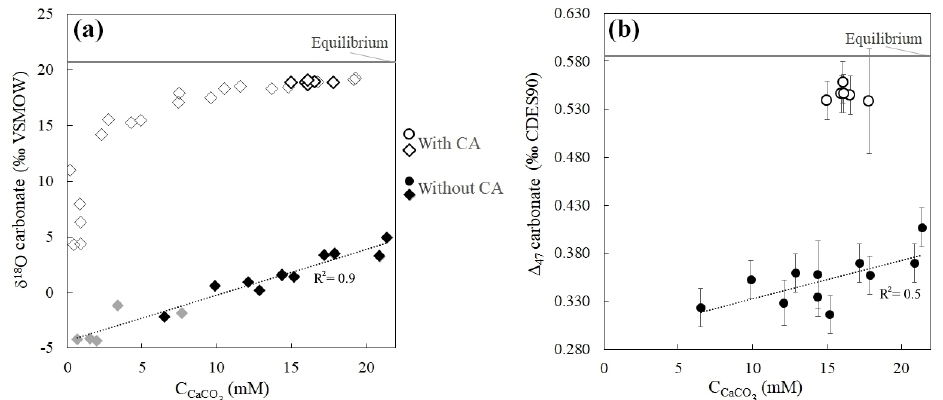
Figure 3. Strong δ 18 O and (cid:49) 47 disequilibria recorded in microbial carbonates as shown by δ 18 O carbonate (a) and (cid:49) 47 (b) values of calcium carbonates (CaCO 3 ) precipitated during bacterial ureolysis at 30 ◦ C (with and without carbonic anhydrase, CA; open and solid symbols, ). Black symbols correspond to samples for which both (cid:49) 47 and δ 18 O mea- respectively) as a function of carbonate accumulation ( C CaCO 3 surements were performed. The grey horizontal lines are equilibrium δ 18 O carbonate and (cid:49) 47 values at 30 ◦ C for calcite following Bonifacie et al. (2017) and Kim and O’Neil (1997) calibrations, respectively. Uncertainties (1 standard deviation, 1SD) are smaller than the symbol for δ 18 O and C CaCO values (Table S1). Reported (cid:49) 47 uncertainties are detailed in Sect. 2 and Sect. S1 in the 3